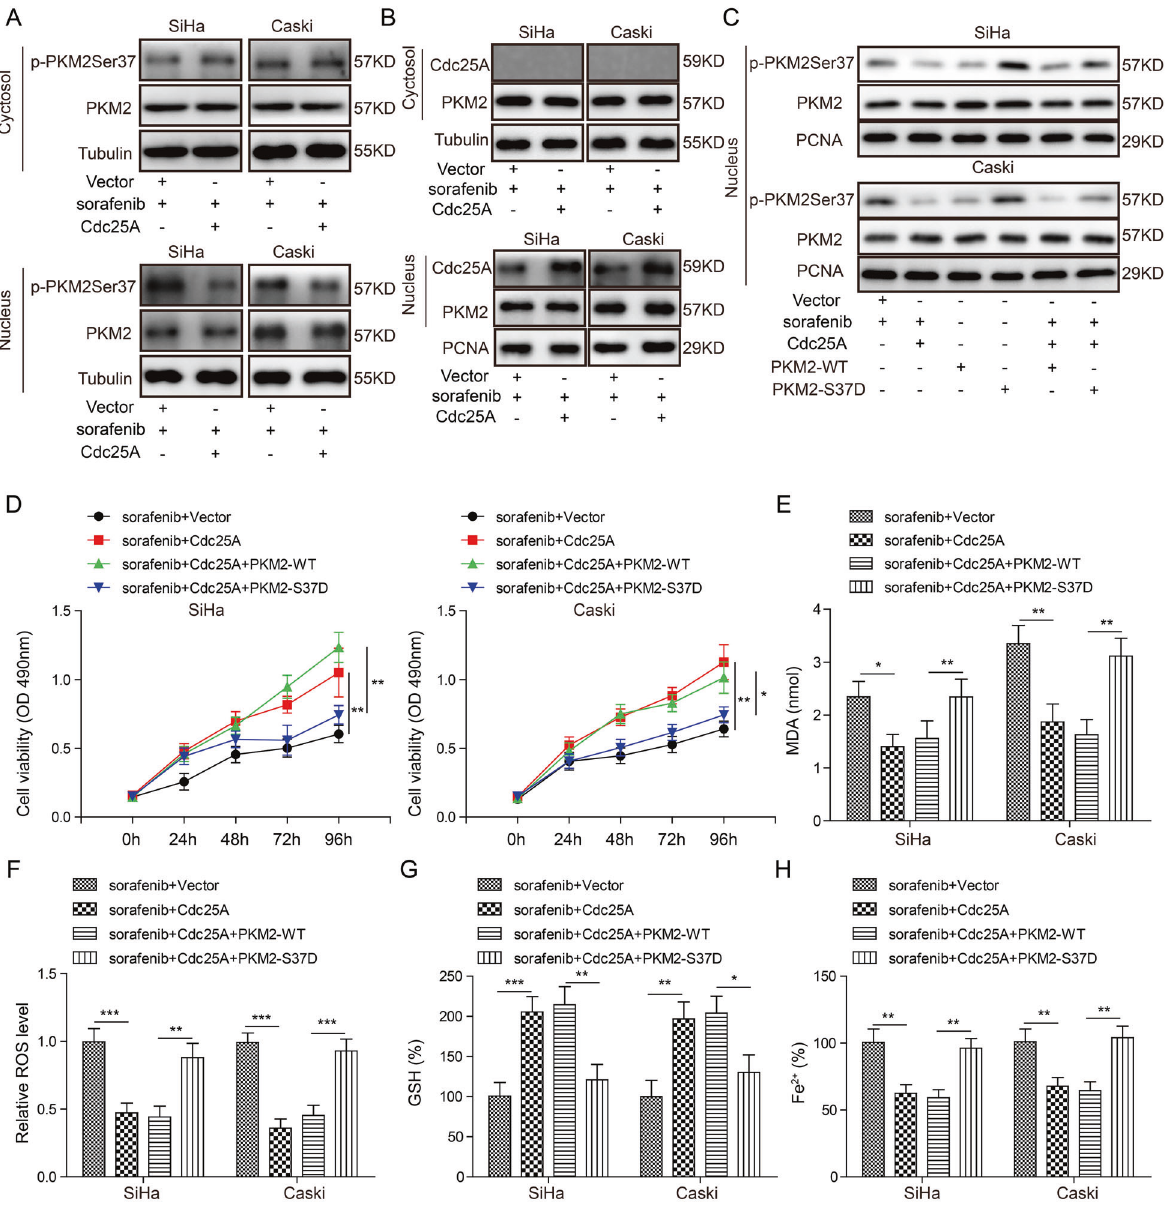
Fig. 4 Cdc25A dephosphorylated PKM2 to suppress sorafenib-induced ferroptosis. A Relative p-PKM2 Ser37 levels in the nucleus and cytosol of transfected cells following sorafenib treatment. B Co-IP was used to analyse the interaction of Cdc25A and PKM2 in the nucleus and cytosol. C Relative p-PKM2 Ser37 levels in transfected cells with or without sorafenib treatment. D The MTT assay to analyse the viability of transfected cells following sorafenib treatment. E Cellular MDA levels in transfected cells after sorafenib treatment. F Cellular ROS levels in transfected cells after sorafenib treatment. G Cellular GSH levels in transfected cells after sorafenib treatment. H Cellular iron levels in transfected cells after sorafenib treatment. Each experiment was repeated three times. * P < 0.05; ** P < 0.01; *** P <